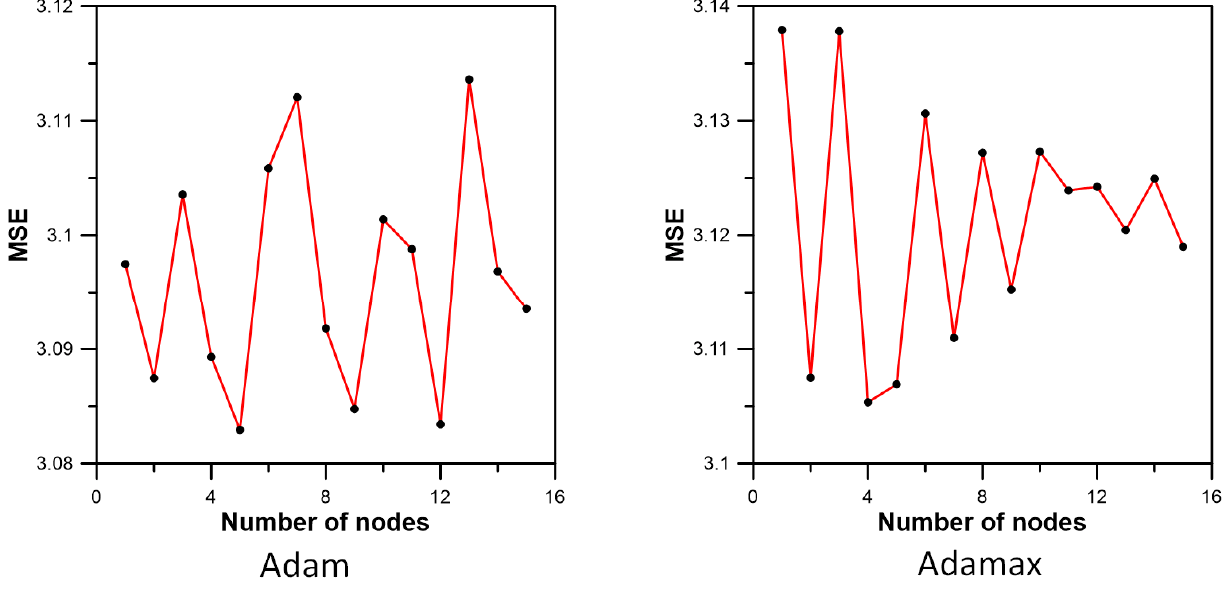
Figure 16. Results according to the number of hidden layers (Adam and Adamax).